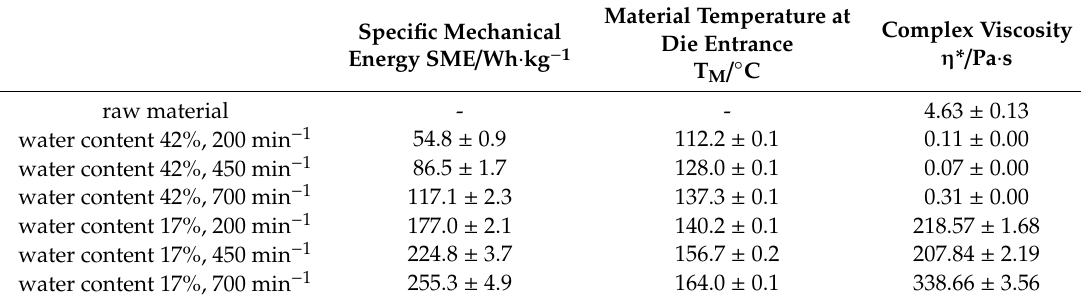
Table 1. The process parameters (specific mechanical energy (SME), material temperature (T M )) and complex viscosity of raw and extruded apple pomace from extrusion trails at a barrel temperature of 100 ◦ C and a total feed rate of 10 kg · h − 1 (published in